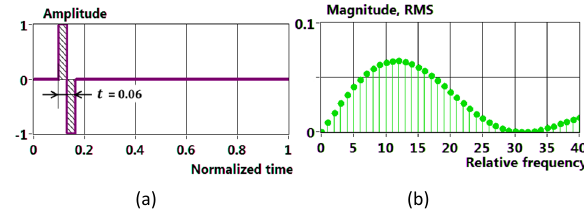
Fig.4: Rectangular waveform (a) and its magnitude spectrum